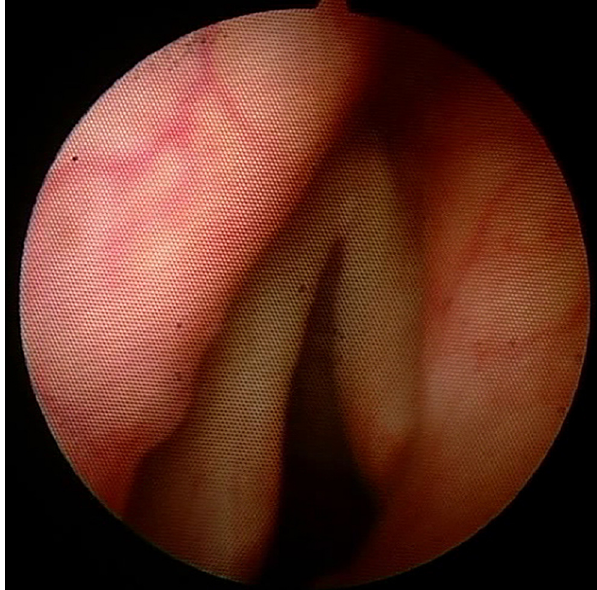
The control endoscopy executed at two months from surgery shows the good increase of the glottic respiratory space.